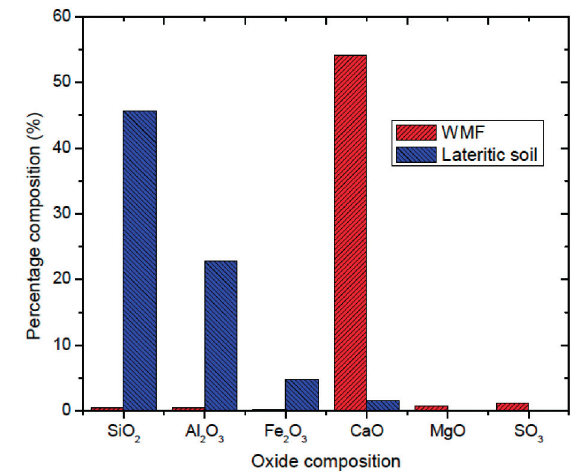
O -SiO -Fe O ternary plot for the 2 3 2 2 3